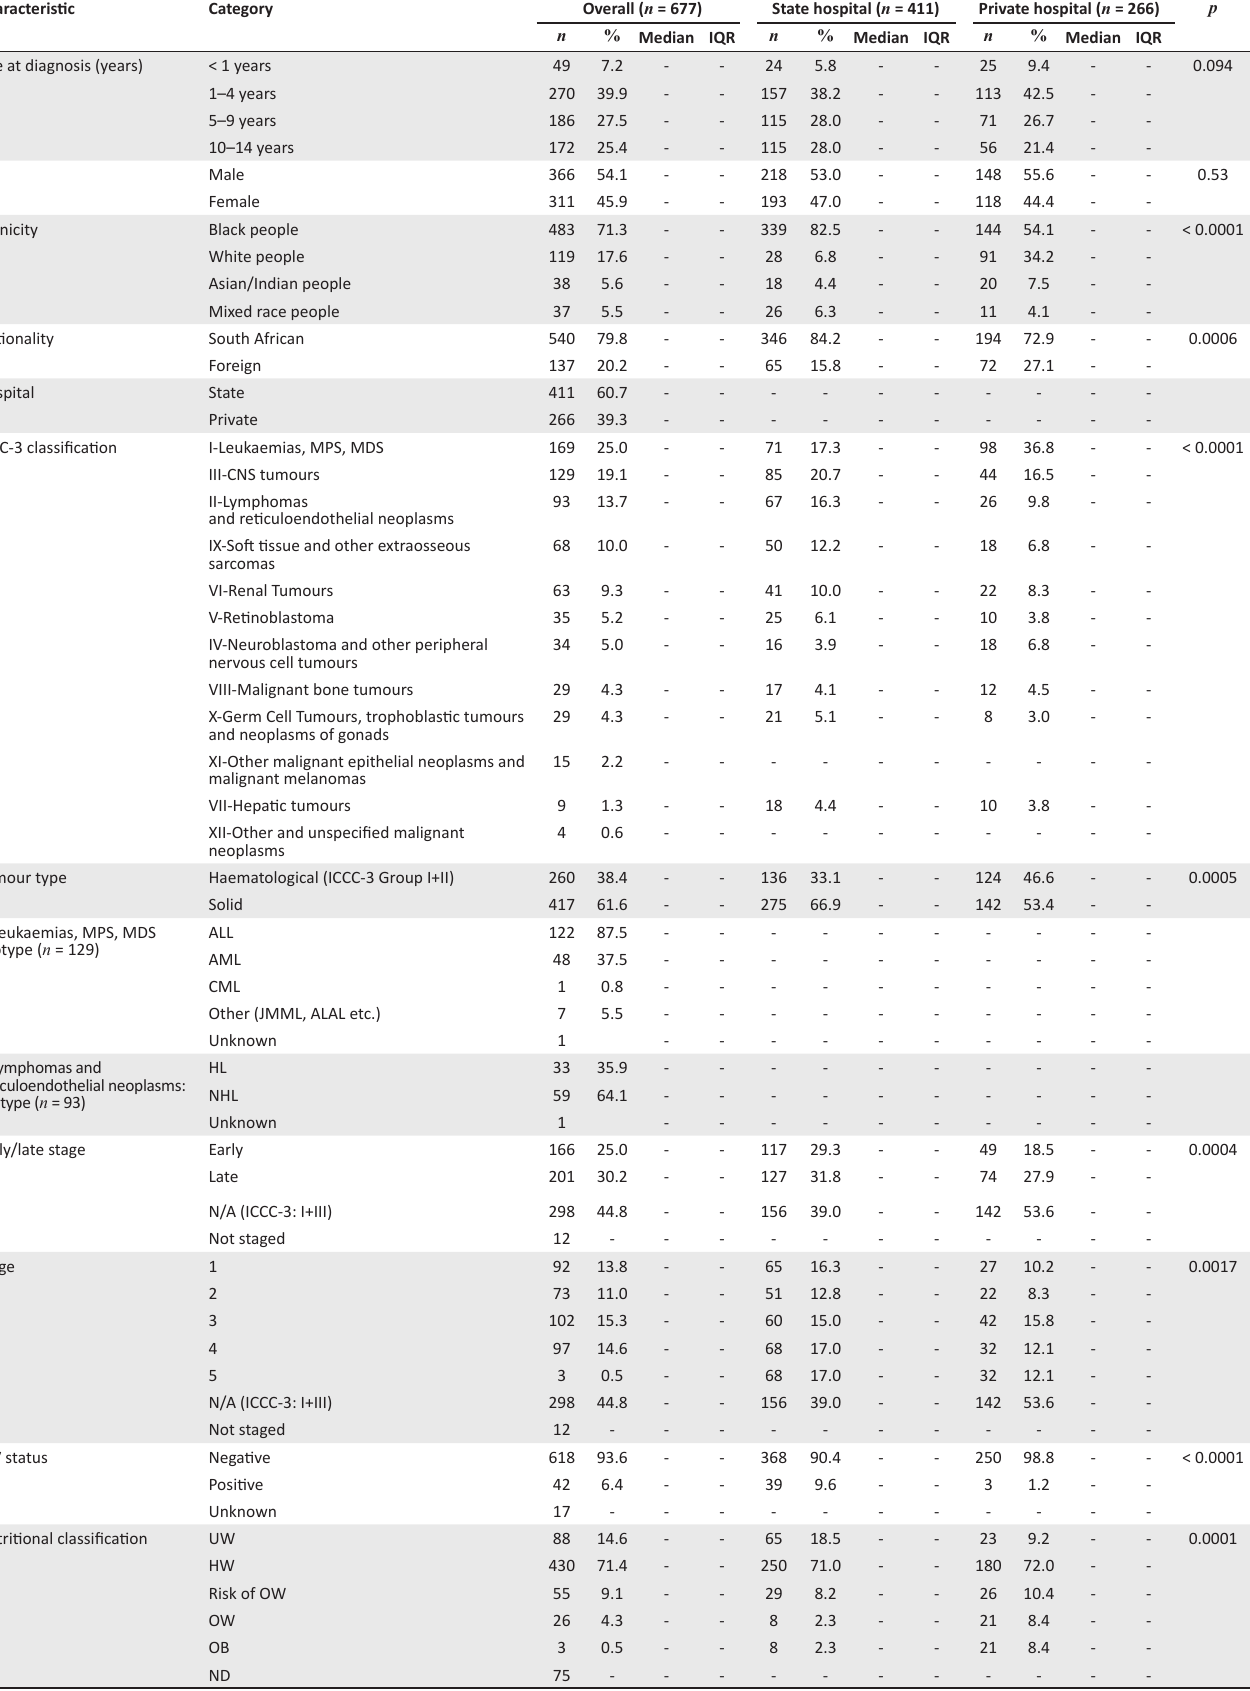
TABLE 1 : Descriptive analysis: State and private hospital.